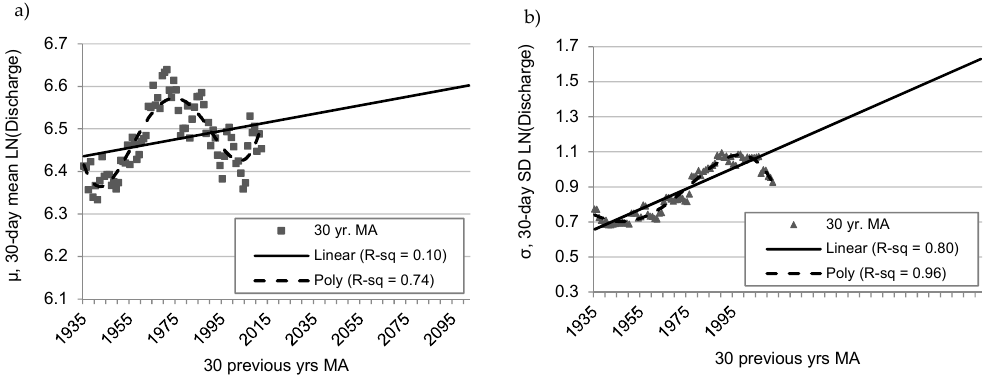
Figure 7. Expected value of 30-year ( a ) average ( µ ) and ( b ) standard deviation ( σ ) of LN-historic observed 3-day average peak annual flows. The solid lines represent long term linear trends fit to the moving average (MA), with fourth degree polynomial trends, displayed with the dashed lines.